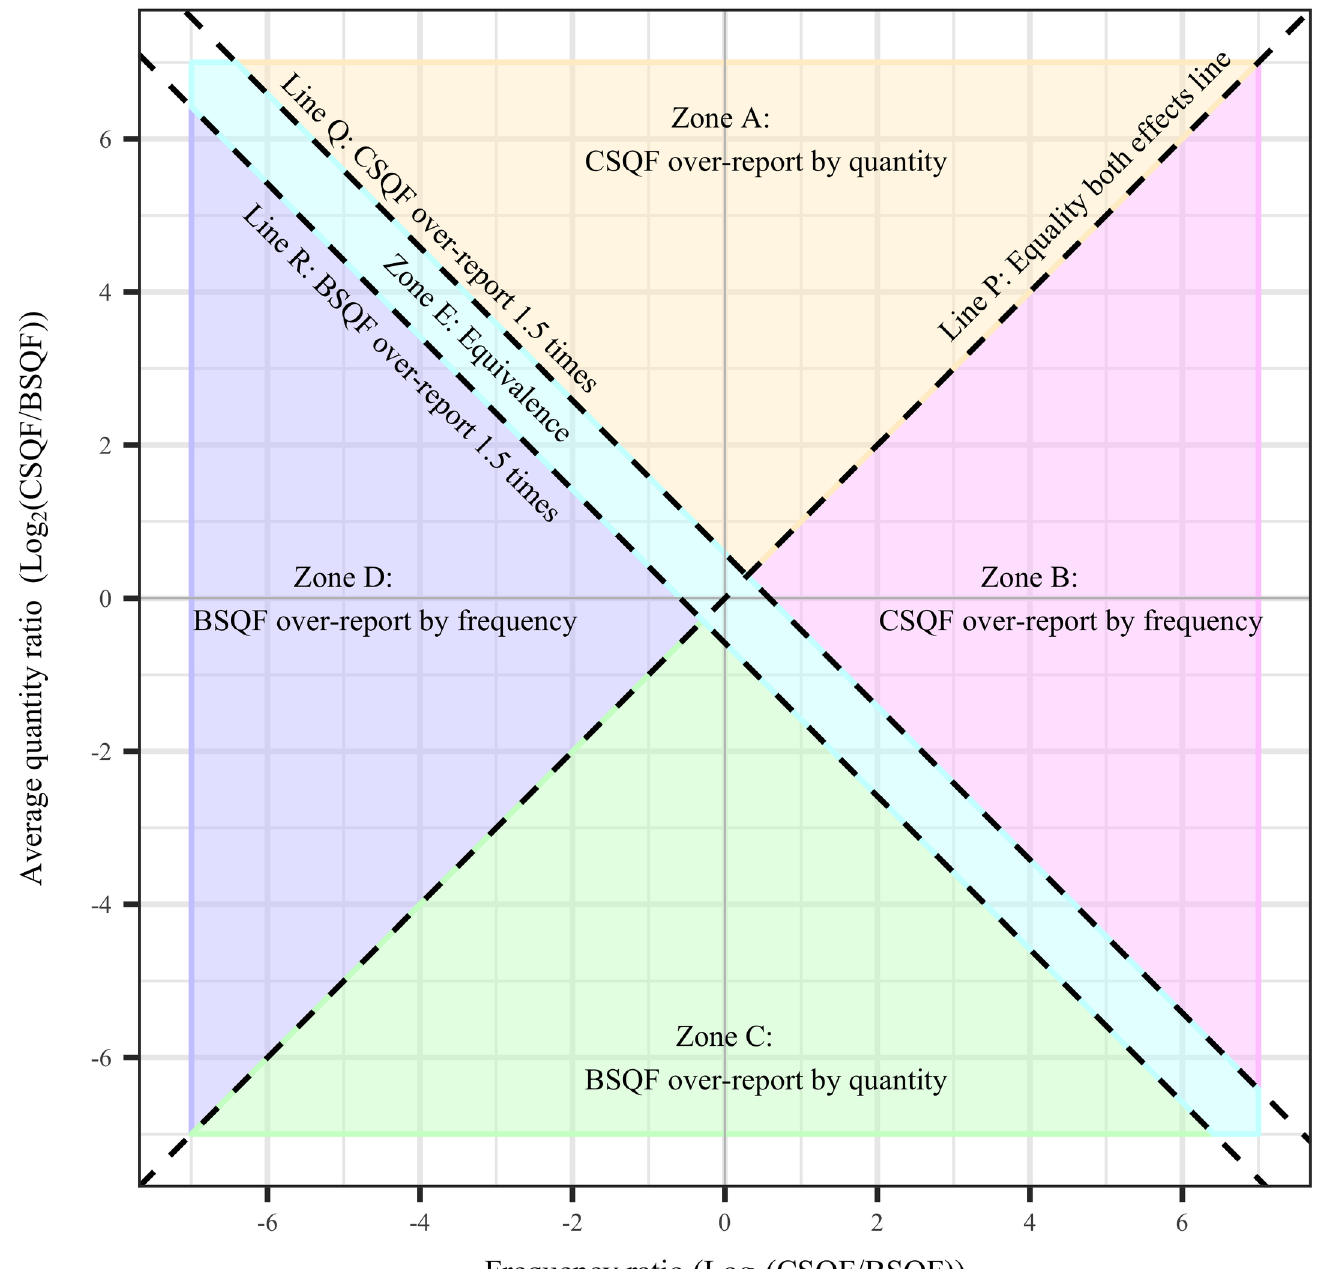
Fig 1. Anatomy of jitter plot of frequency ratio and average quantity ratio with five zones. https://doi.org/10.1371/journal.pone.0202756.g001 PLOS ONE | https://doi.org/10.1371/journal.pone.0202756 August 17,